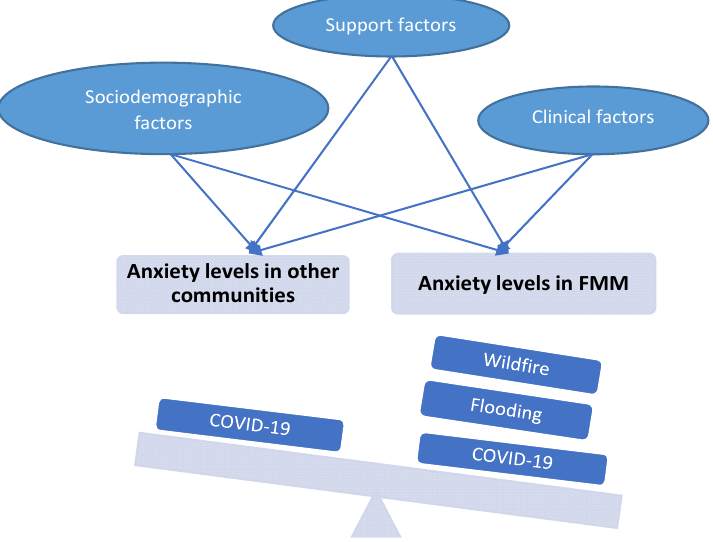
Figure 1. Conceptual framework for the prospective impact of multiple traumas and the predictive factors for high anxiety levels in Fort McMurray (FMM) community versus other communities.